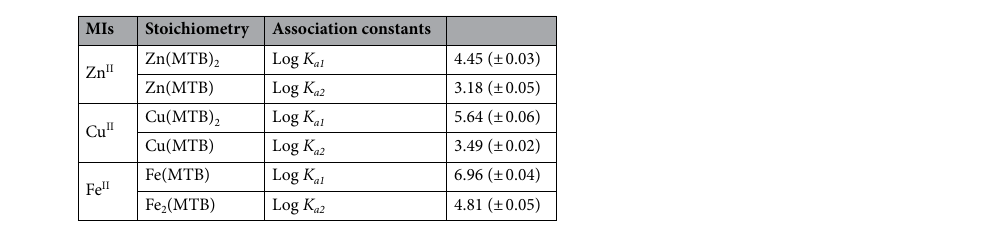
Table 3. The stoichiometry and association constants of MTB complexes with Zn II , Cu II , and Fe II at the aqueous solution (pH 5). Numbers in parentheses indicate the standard deviation values (n = 3).